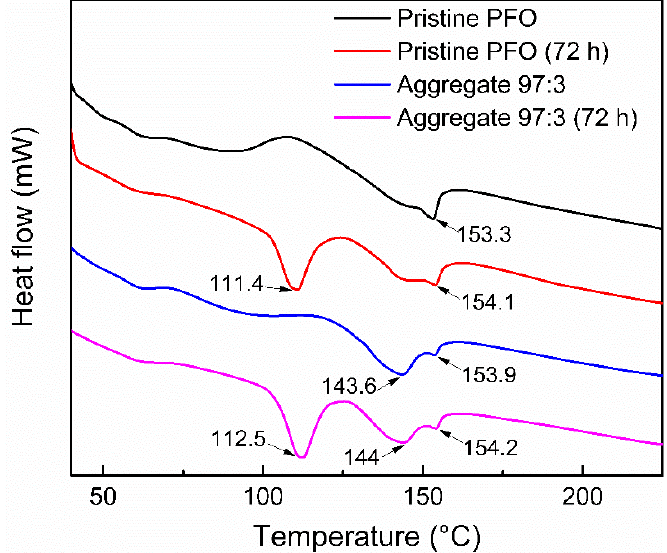
Figure 5. DSC heating curves of pristine PFO films and 97:3 aggregated PFO films before and after thermal degradation test at 90 °C for 72 h.